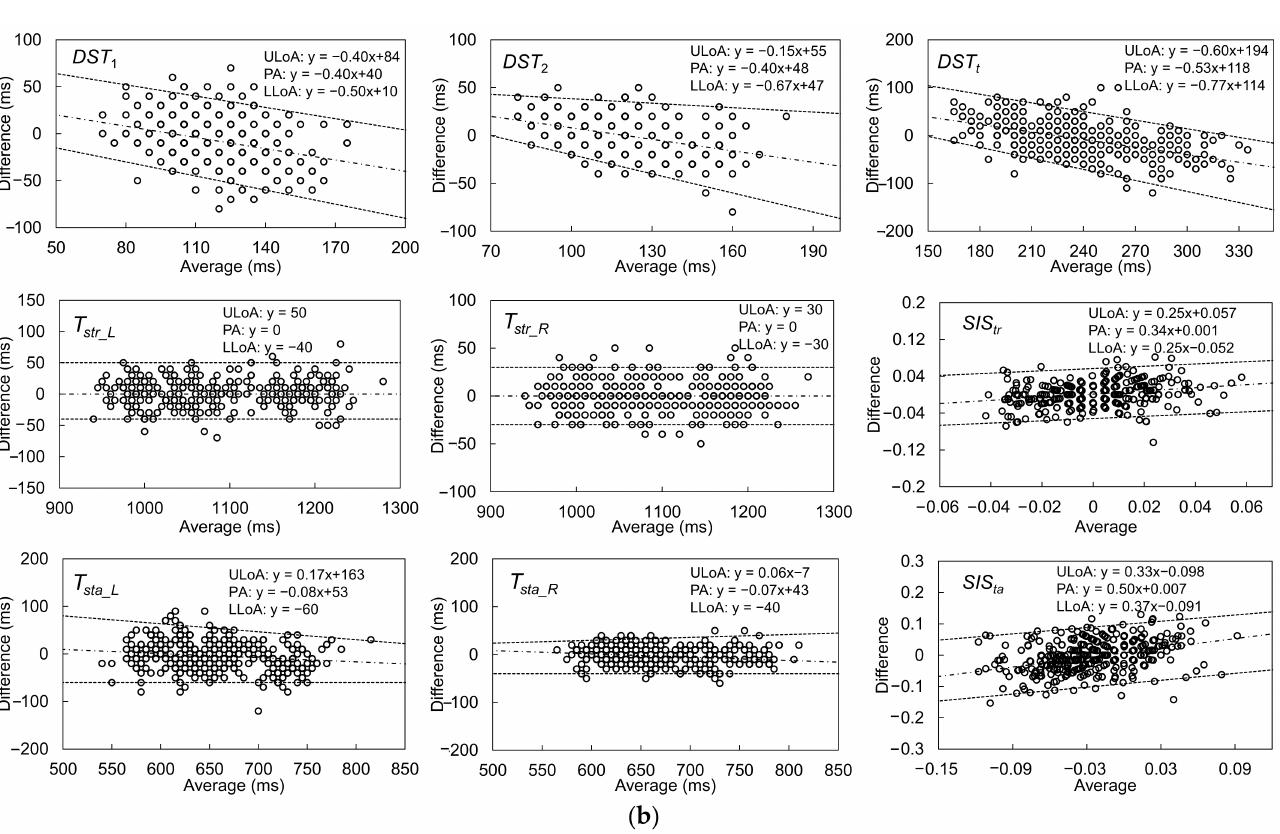
Figure 11. ( a ) Agreement plots between the IMS and Vicon results for gait parameters measured from one stride, including DST 1 , DST 2 , DST t , T str_L , T str_R , SIS tr , T sta_L , T sta_R , and SIS ta . ( b ) Bland–Altman plots and LoAs of the 95% confidence interval around the PA line for comparison of the one-stride IMS and Vicon gait parameter measurement results. The black dashed lines are the PA lines, and each pair of black dotted lines represents the ULoA and LLoA. The LoAs of the parameters judged as having a proportional bias were corrected by a nonparametric approach via quantile